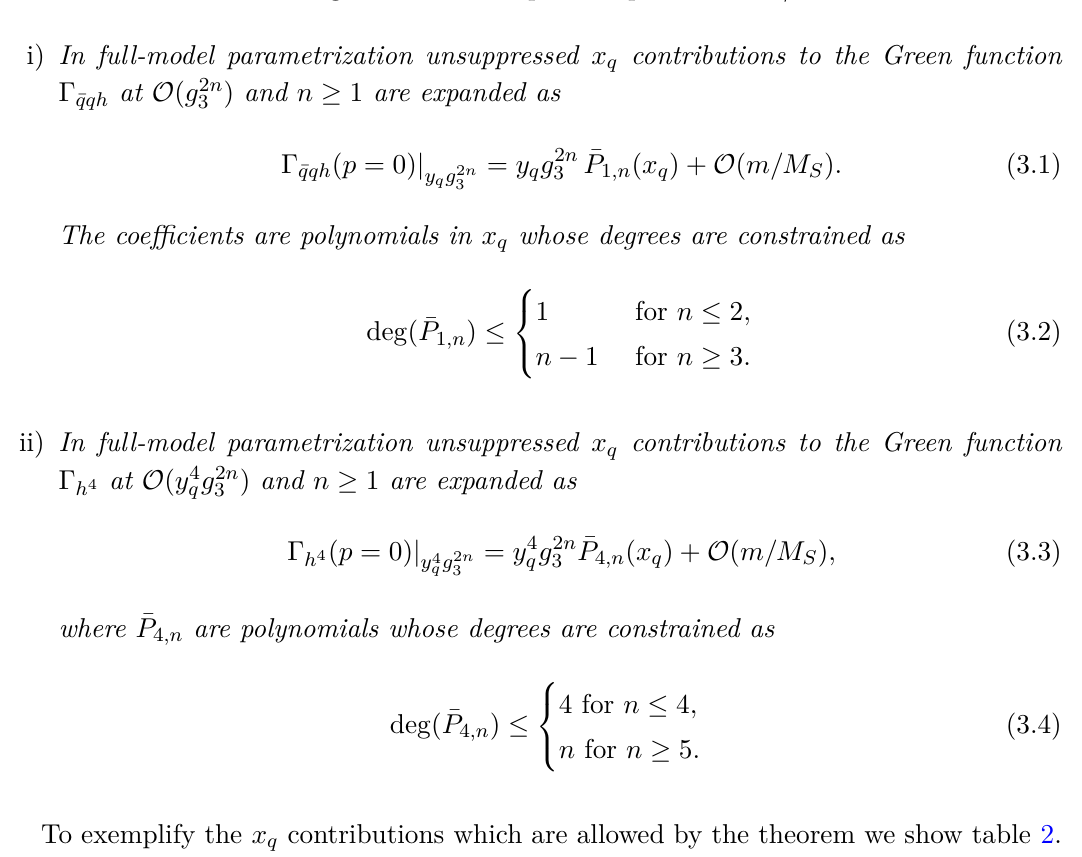
splitting between the SM fields and the SUSY scale m < M the Green function at leading order in the expansion parameter m/M